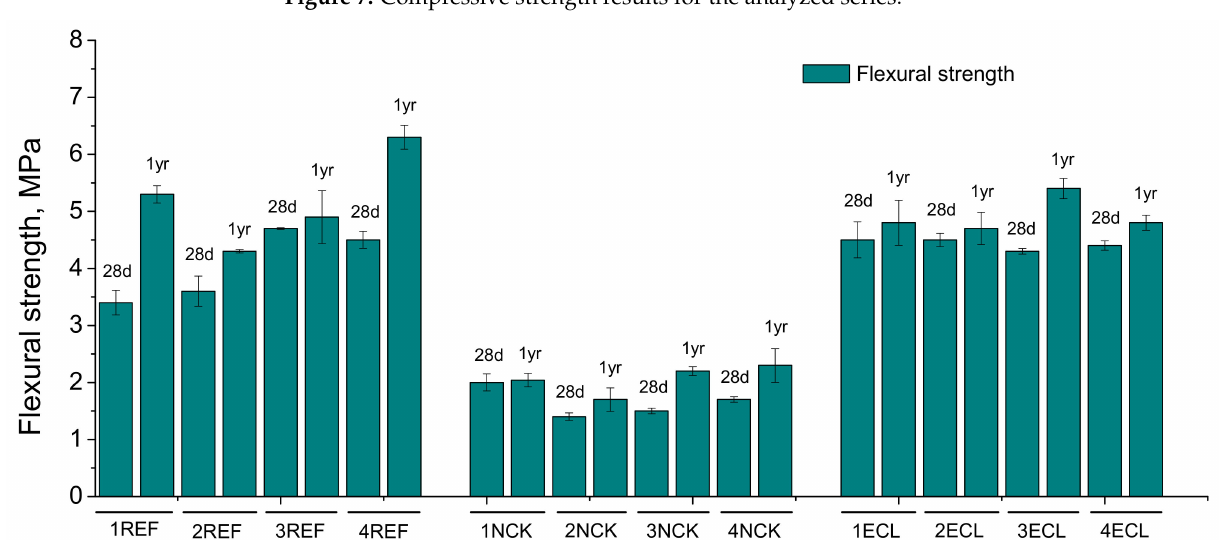
Figure 8. Flexural strength results for the analyzed